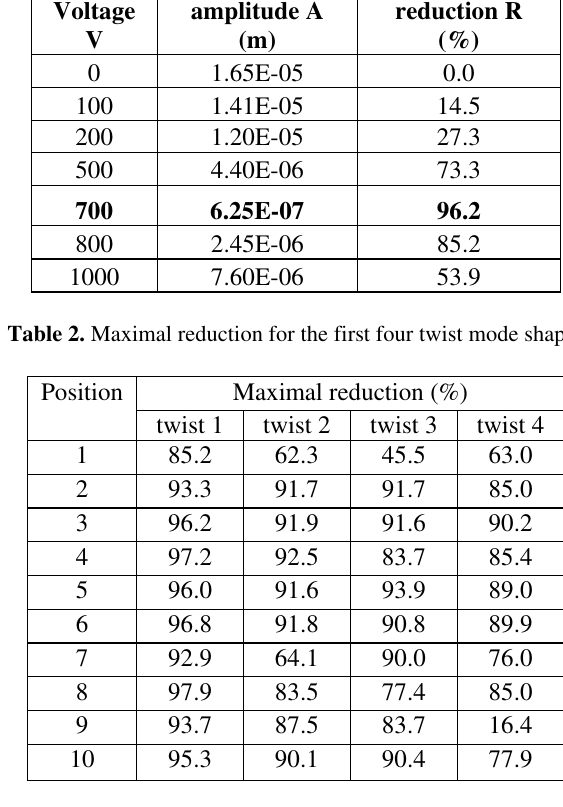
Table 3. Optimal voltage for the first four twist mode